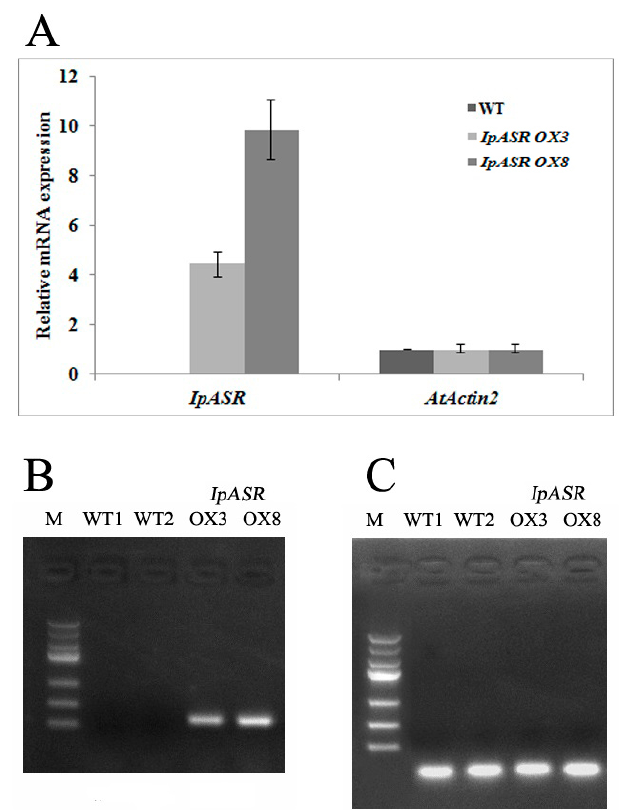
Figure 7. Overexpression analyses of IpASR in transgenic Arabidopsis lines ( IpASR OX3 and IpASR OX8 ). ( A ) Quantitative RT-PCR analysis of IpASR in transgenic Arabidopsis lines and wild type (WT) Arabidopsis . Actin2 was used as an internal control. Error bars indicate the SD based on three replicates. ( B ) RT-PCR analysis of IpASR in transgenic Arabidopsis lines and two WT lines. ( C ) RT-PCR analysis of AtACT2 in transgenic Arabidopsis lines and two WT lines as a control.